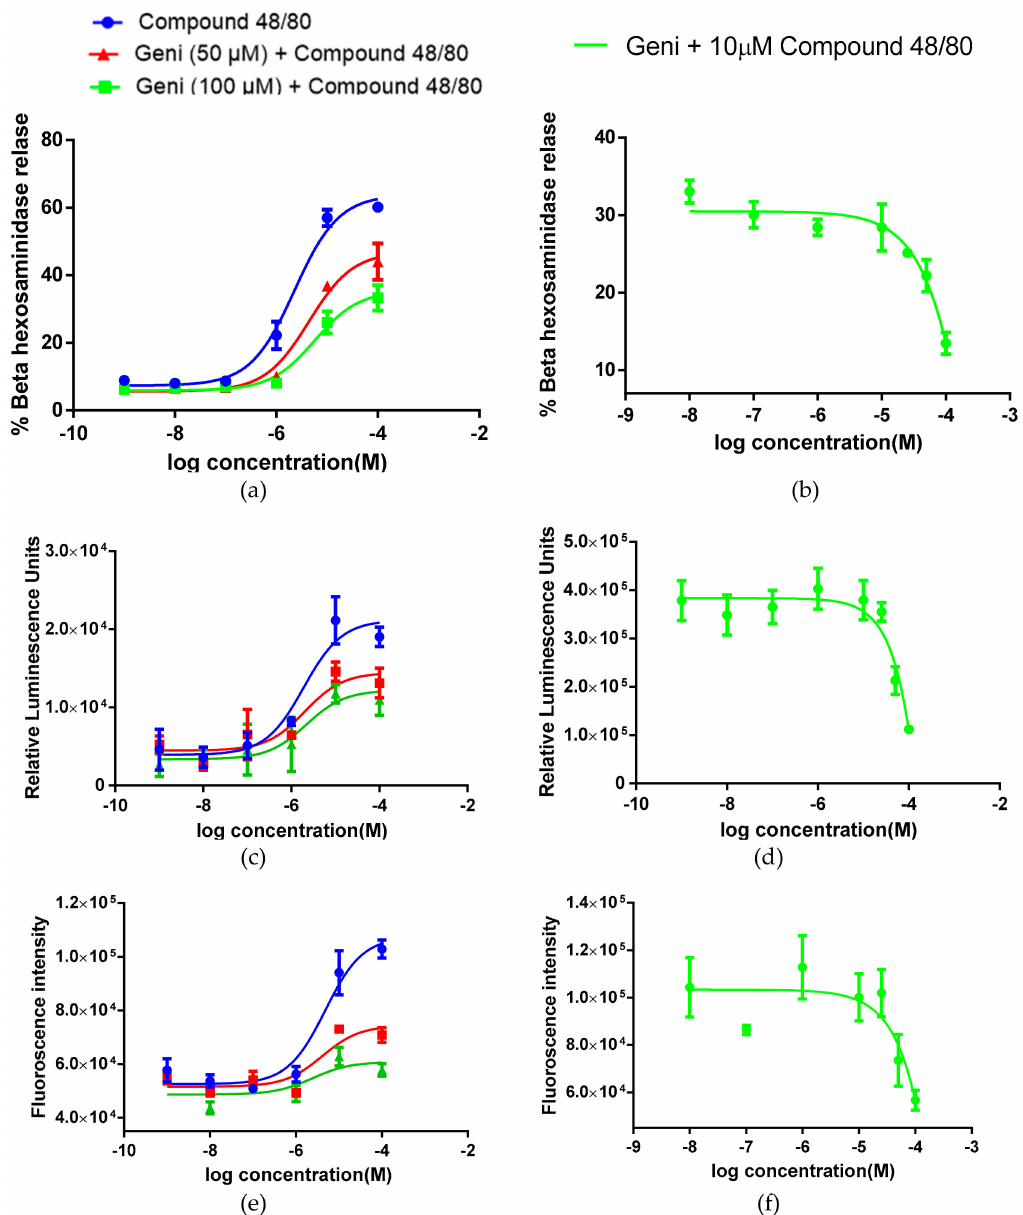
Figure 2. Genistein inhibited human mast cell degranulation. For EC50 shift estimation, we plotted a graph of log concentration (compound 48 / 80) vs. response (% β -hexosaminidase release) in the presence of bu ff er, and genistein 50 µ M, and 100 µ M ( a ). The Dose–Response Curve (DRC) of Genistein for IC50 estimation via mast cell degranulation assay ( b ). Genistein inhibited Mas related GPCRX2 (MRGPRX2) activation measure by PRESTO-Tango assay, DRC of compound 48 / 80 in the presence of bu ff er, and Genistein 50 µ M, and 100 µ M ( c ). The DRC of Genistein for IC50 estimation via MRGPRX2 activation assay ( d ). Genistein inhibited calcium flux in Human LAD-2 mast cells. The DRC of compound 48 / 80 in the presence of bu ff er, and Genistein 50 µ M, and 100 µ M ( e ). IC50 of Genistein was estimated via plotting a graph between log concentration (Genistein) vs. response (fluorescence intensity) ( f ). Each data represents the means ± SEM of three independent